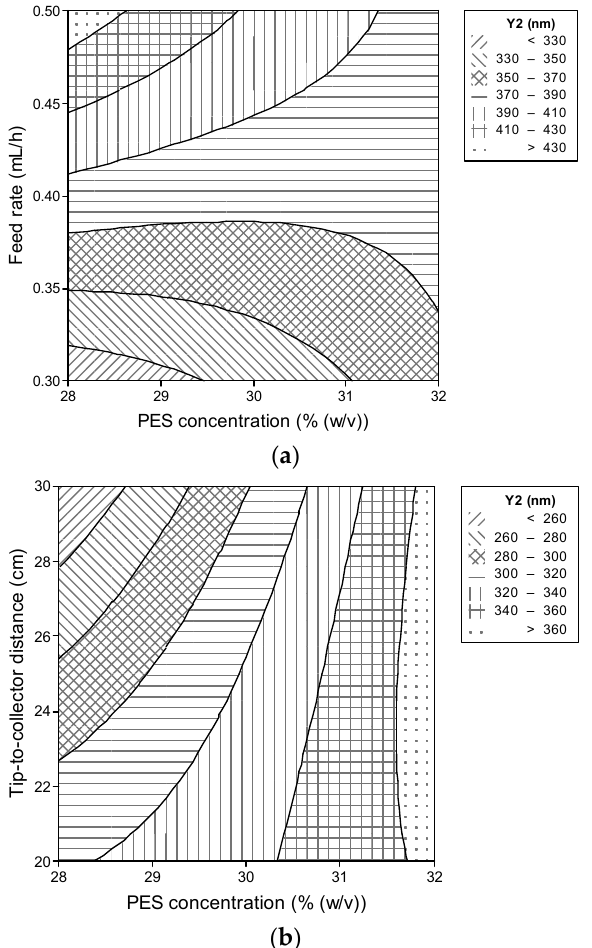
Figure 2. Contour plot for the average fiber diameter (Y 2 , nm) as a function of feed rate and PES concentration at an LiCl concentration of 0.01% (w/v) and a tip-to-collector distance of 20 cm ( a ); as a function of the tip-to-collector distance and the PES concentration at an LiCl concentration of 0.01% (w/v) and a feed rate of 0.3 mL/h ( b ).